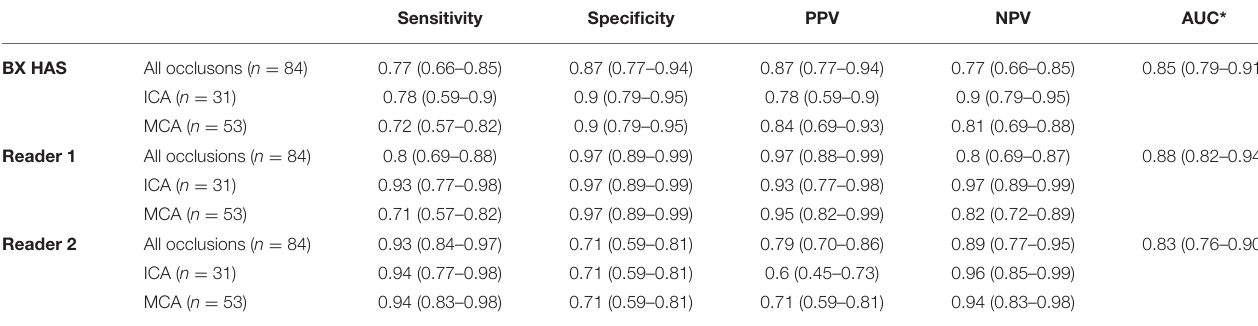
TABLE 2 | Accuracy for correct detection of hyperdense artery sign on the correct side for all occlusions as well as ICA and MCA (M1 and 2) occlusions separately. Sensitivity